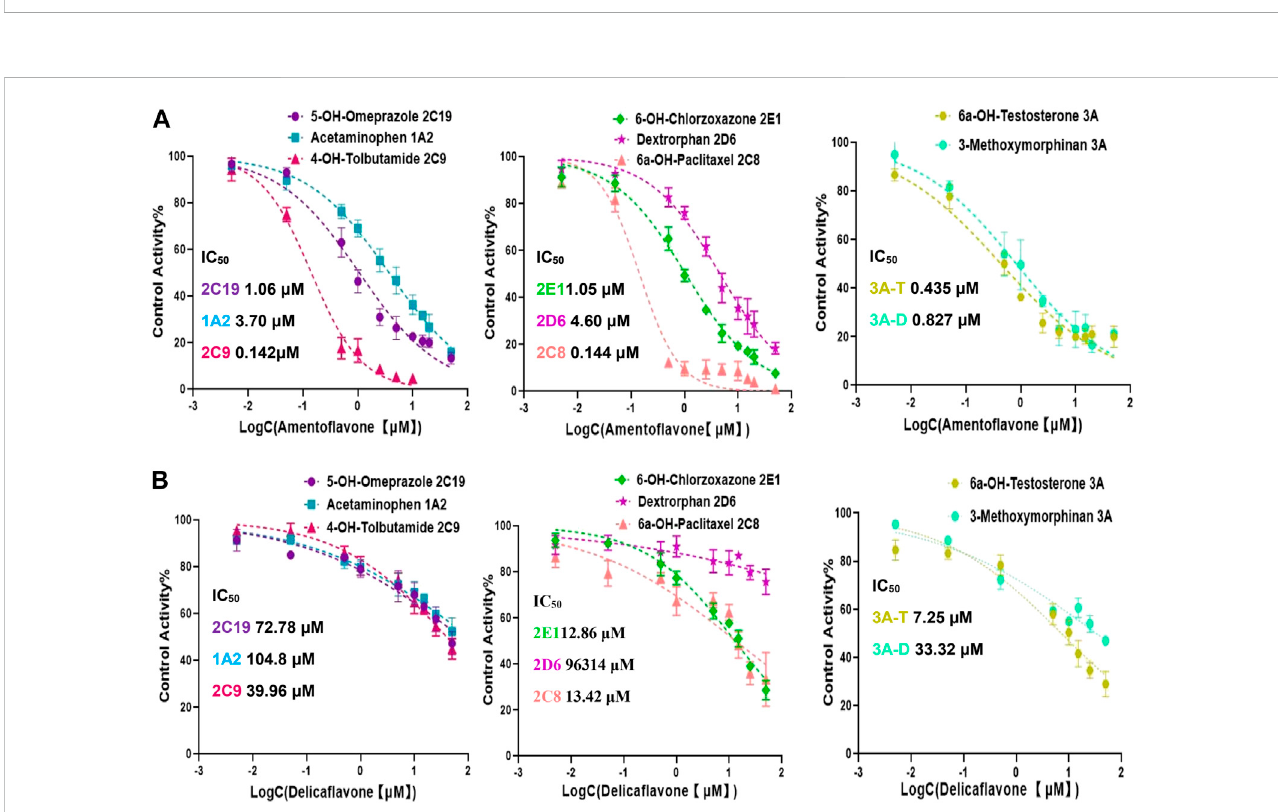
FIGURE 5 Inhibition curves and IC 50 values of Amento fl avone (A) and Delica fl avone (B) against seven CYP450 isoforms. Note: 3A-T, CYP3A (Testosterone); 3A-D, CYP3A (Dextromethorphan).